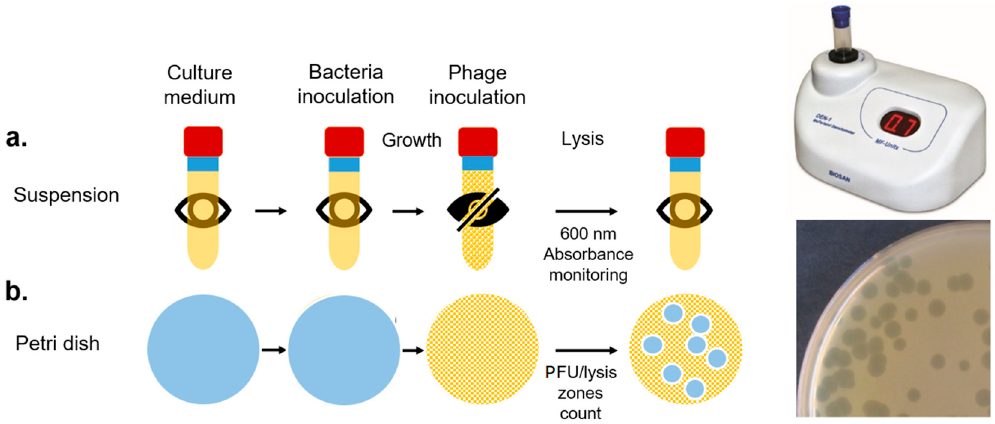
Figure 3. Representation of the turbidity ( a ) and plaque assay ( b ) methods for the detection of bacteriophage contaminations. PFU: plaque forming unit.